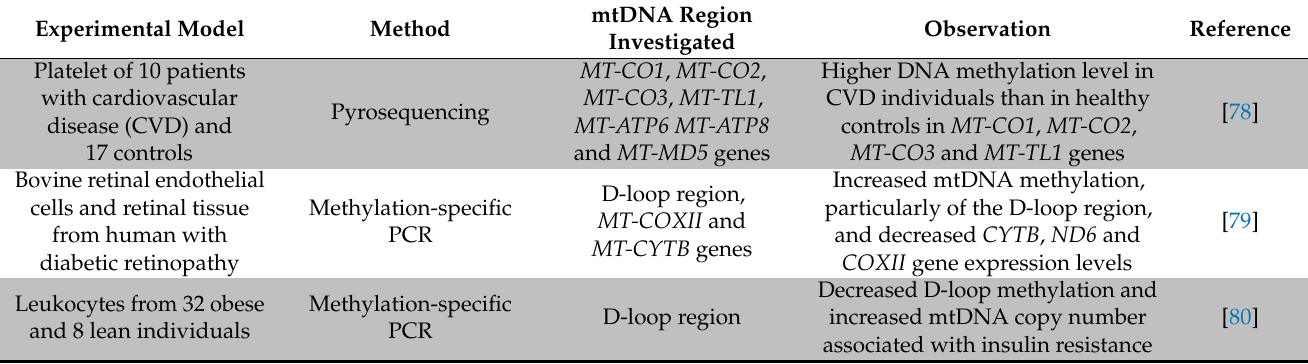
Table 2. mtDNA methylation studies in metabolic disorders and cardiovascular